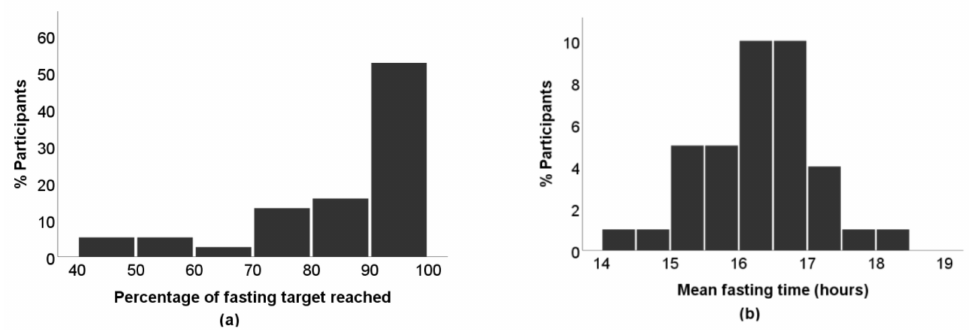
Figure 1. ( a ) Percentage of days where the fasting target was reached of all recorded days per participant, x axis subdivided into categories of 10% each; ( b ) mean fasting hours of all recorded days per participant, x axis subdivided into categories of 0.5 hours